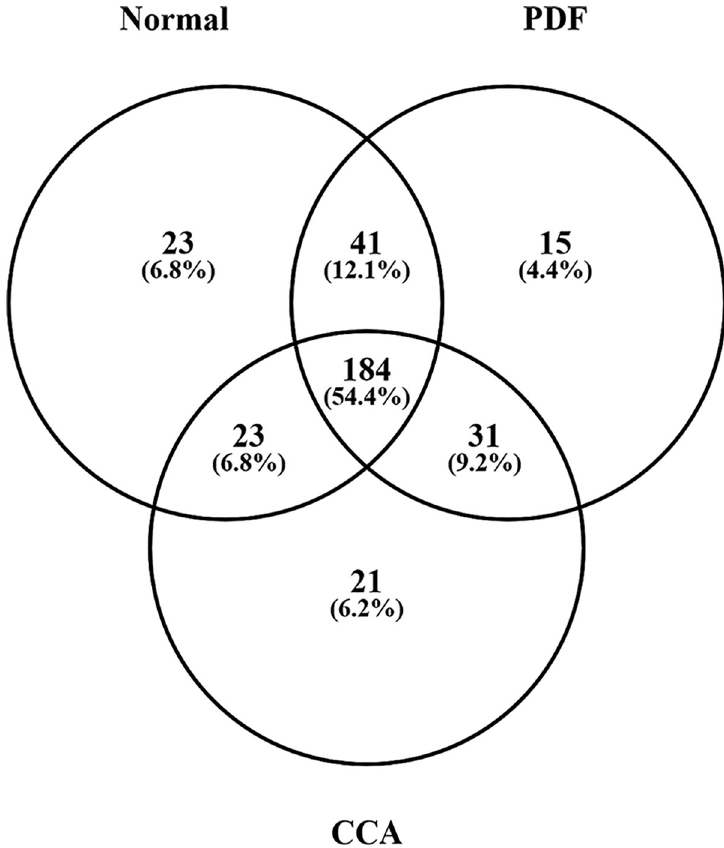
Fig 2. Urinary biomarker discovery. Venn diagram represents the overlap among protein sample types with 338 identified proteins.